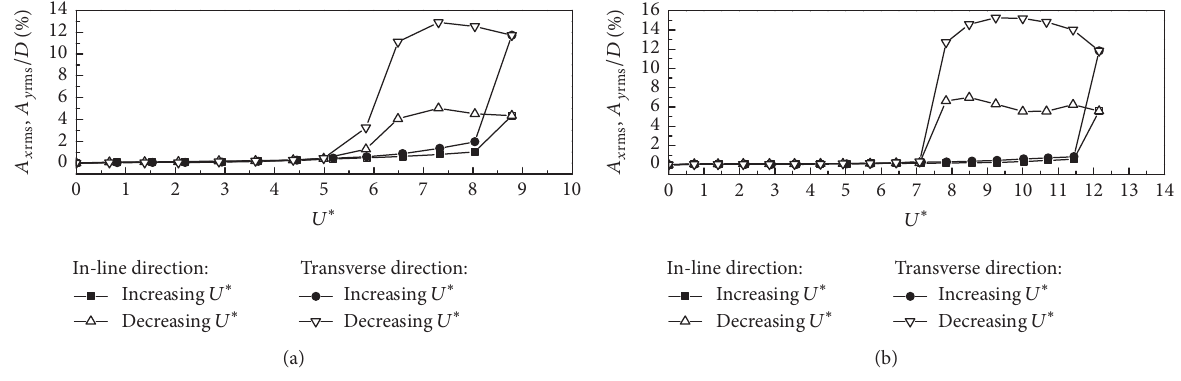
Figure 7: Root-mean-square response amplitudes. (a) Aluminum tube and (b) stainless steel